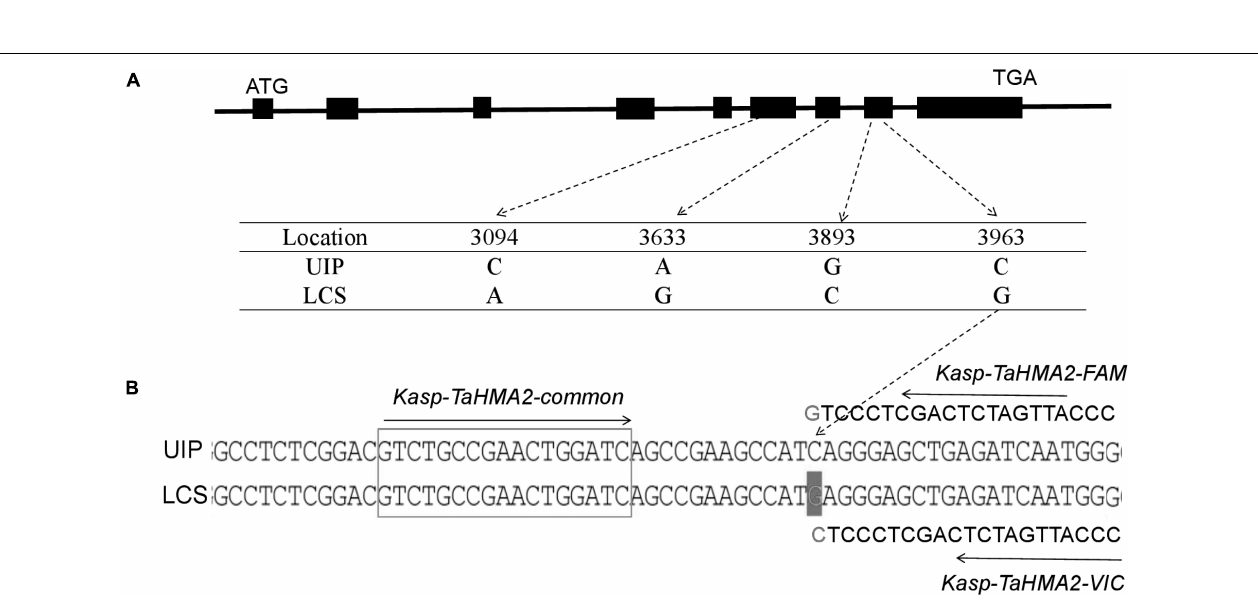
FIGURE 3 | Sequence comparison of TaHMA2 in two parents and KASP marker associated with the candidate gene. (A) Schematic diagram of nucleotide polymorphism for TaHMA2 . The polymorphic site and relative positions are indicated on the genomic sequence of TaHMA2 . Exons are indicated by black boxes, flanking regions and introns are indicated by solid black lines. (B) A KASP marker was designed using the nucleotide polymorphism of TaHMA2 .